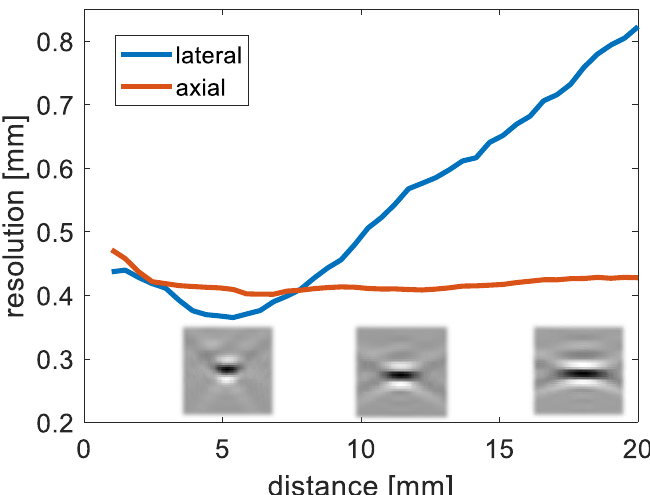
Figure 4. The lateral and axial widths of the point spread function, obtained for the different distances from the probe. Images of the reconstructed point spread functions, cropped to a square with a side length of 2 mm, are shown for distances of 5, 12.5, and 20 mm.